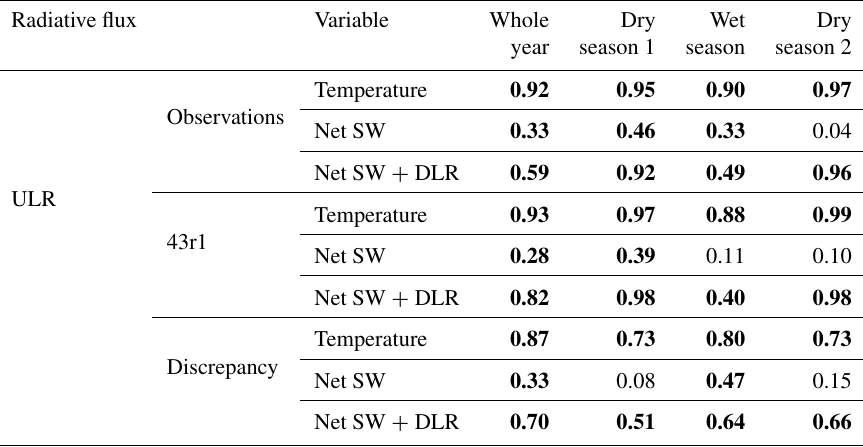
Table 6. Upwelling longwave surface fluxes: r 2 values from correlations between observed and 43r1 ULR, and their discrepancy, to other variables for the whole year (days 7–341), first dry season (days 7–125), wet season (days 126–301) and second dry season (days 302–341); statistically significant (to p ≤ 0.001) values are in bold. Italics indicate which variables were used in the linear model.